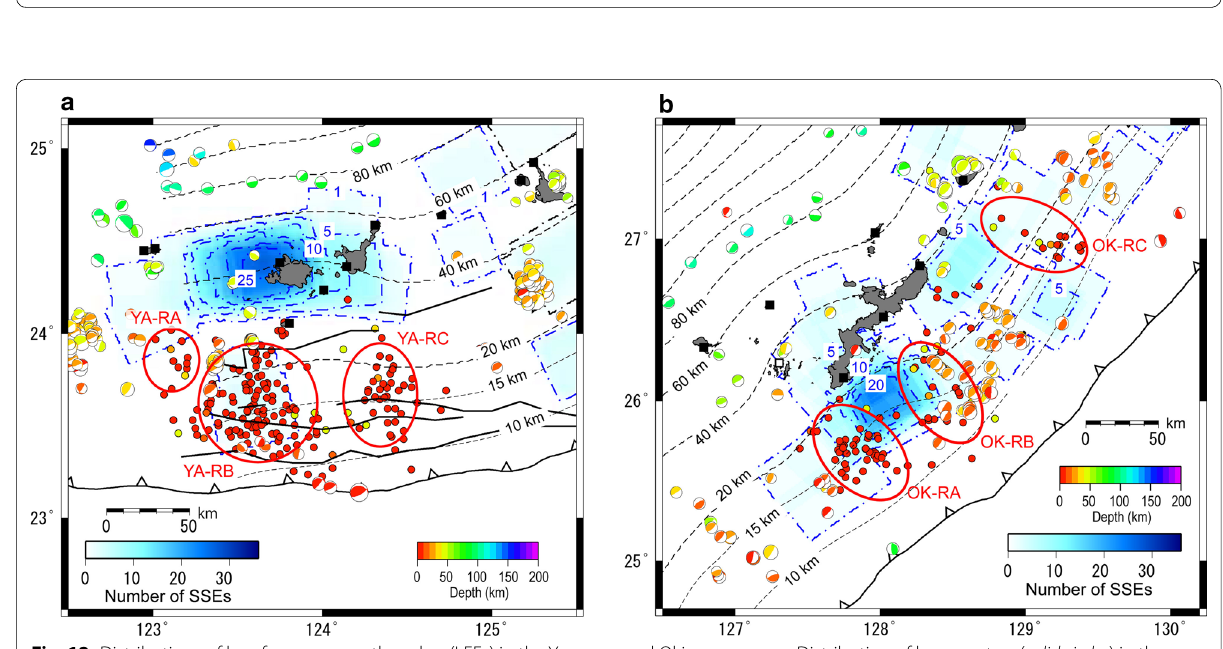
Fig. 12 Distributions of low-frequency earthquakes (LFEs) in the Yaeyama and Okinawa areas. a Distribution of hypocenters ( solid circles ) in the Yaeyama area. The centroid moment tensor (CMT) solutions are thrust-fault events (Mw > 3.5), which were selected from the F-net catalog of the National Research Institute for Earth Science and Disaster Resilience. The color of the CMT solutions indicates the depth of the event. Thick and thin dashed lines show the contours of the subducted Philippine Sea Plate, produced using SLAB1.0 (Hayes et al. 2012). Color map with blue long and short dashed lines shows the numbers of SSE faults (Nishimura 2014). b Same as a but for the Okinawa